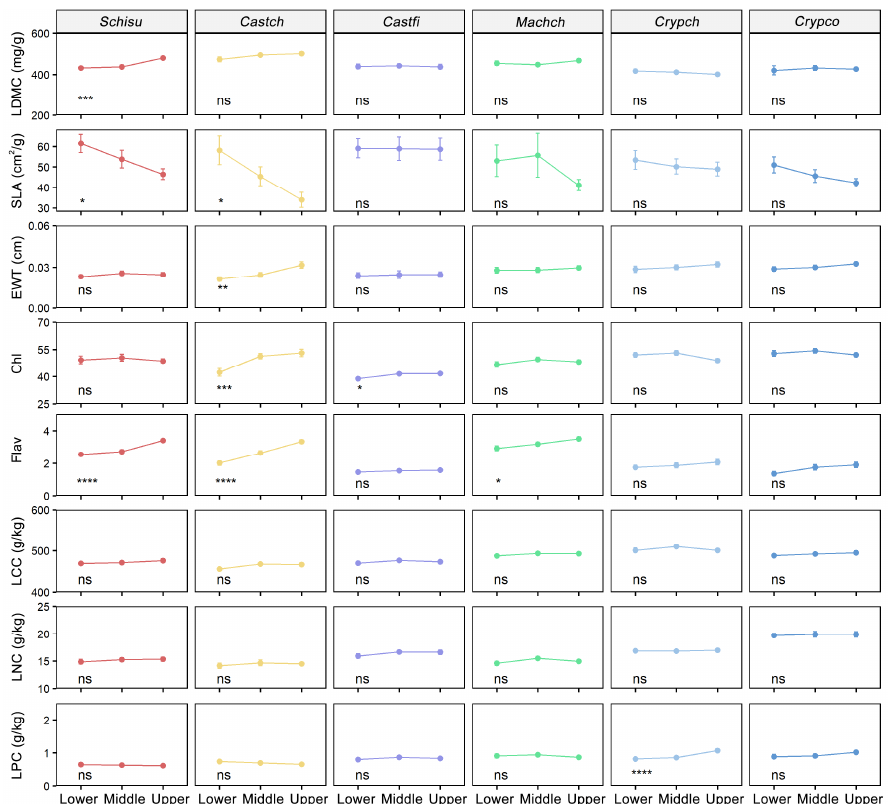
Figure 4. Variation of eight leaf traits in each tree species across three canopy layers (lower, middle and upper). The symbols ****, ***, **, and * represent significance at the 0.0001, 0.001, 0.01 and 0.05 levels, respectively. The symbol ns indicates no significant difference ( p > 0.05).